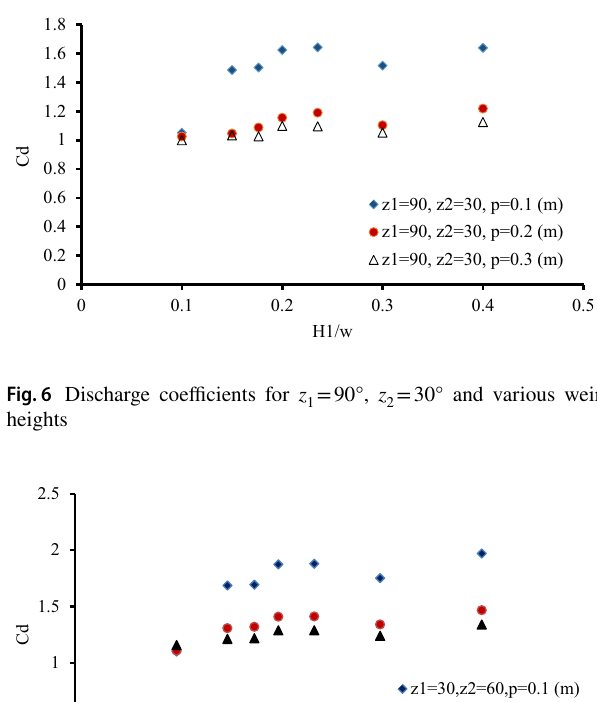
z 1 = 30°, 2 = 60° and various weir